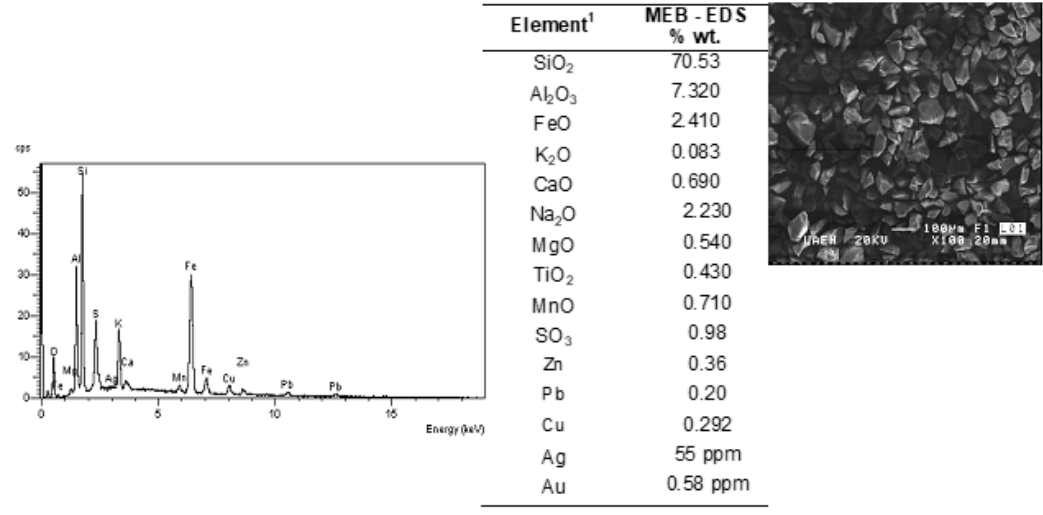
Figure 4. SEM images of MW particles, EDS spectra, and semiquantitative analysis.